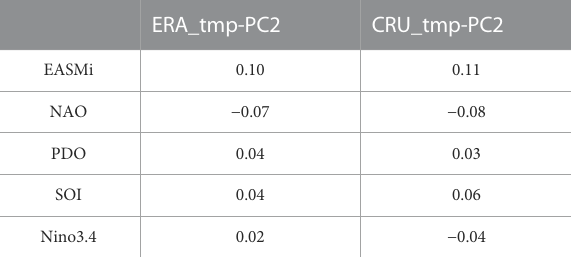
TABLE 1 Correlation coef fi cients between PC2 and the other climate indices.